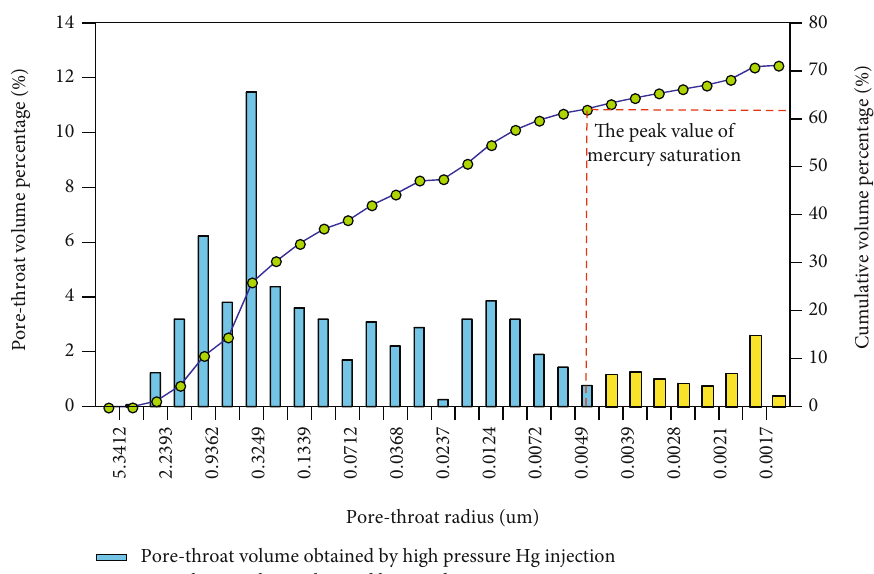
Figure 10: Pore-throat radius distribution features in high-pressure mercury penetration and nitrogen adsorption.